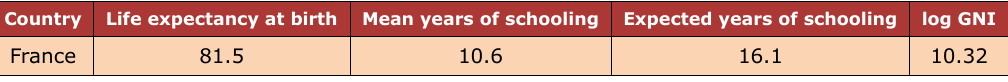
Table 1. Data related to four human development indicators for France